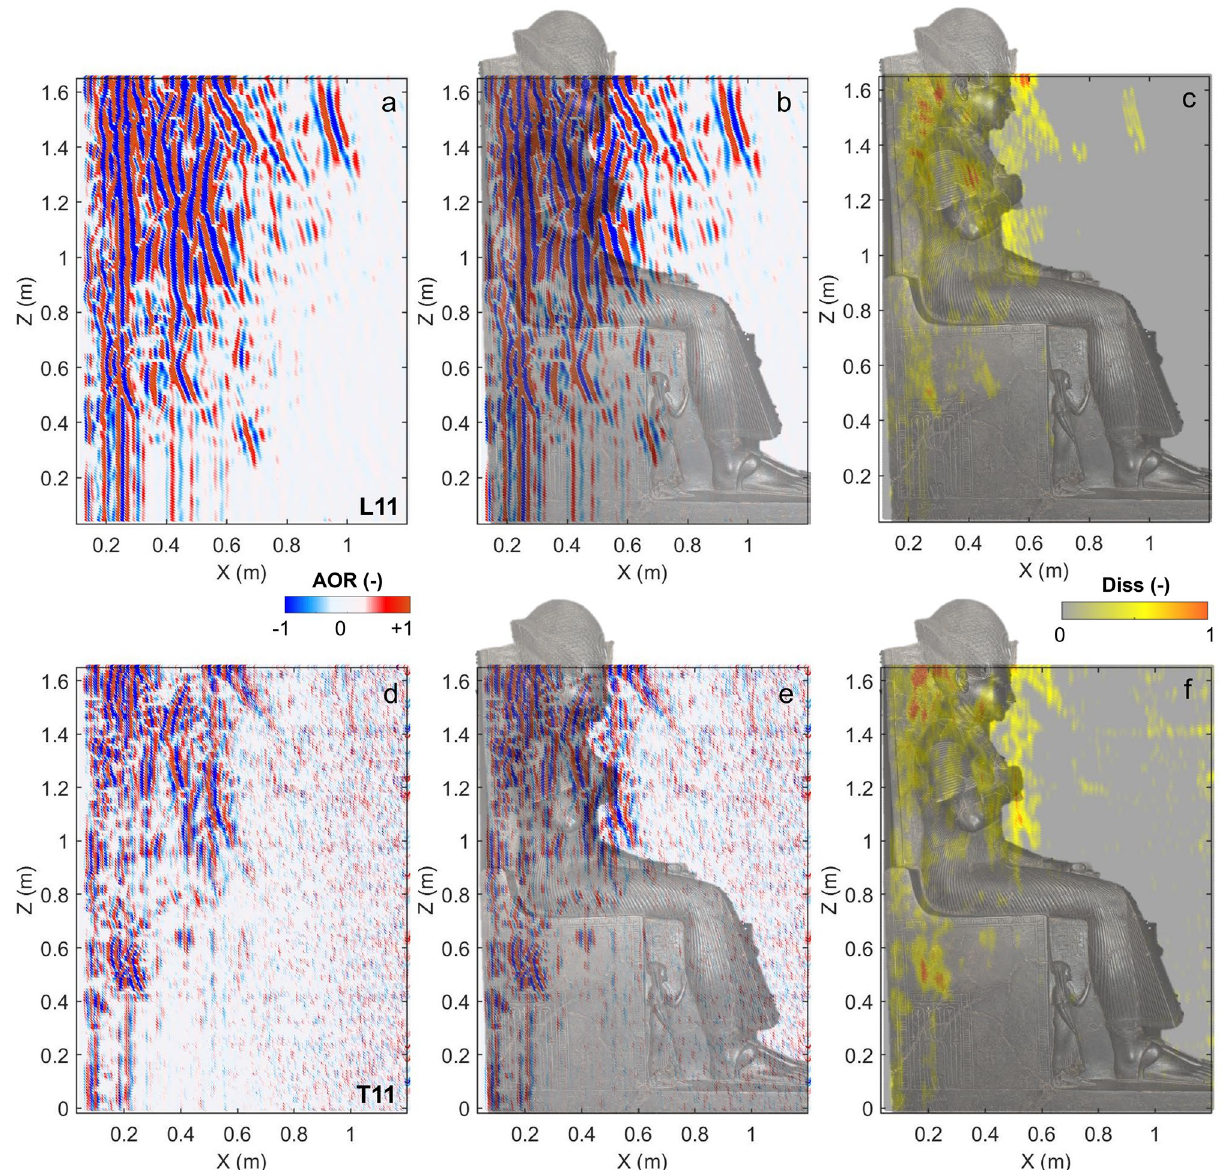
Figure 4. Comparison of GPR results obtained in dual polarization along the radar scan P11. ( a – c ) Longitudinal polarization (L11): ( a ) processed radargram, ( b ) processed radargram with the overlapped image of the statue, ( c ) local dissimilarity. ( d – f ) Transverse polarization (T11): ( d ) processed radargram, ( e ) processed radargram with the overlapped image of the statue, ( f ) local dissimilarity. Figure created in Matlab (version R2021b, https:// it. mathw orks. com/ produ cts/ matlab.